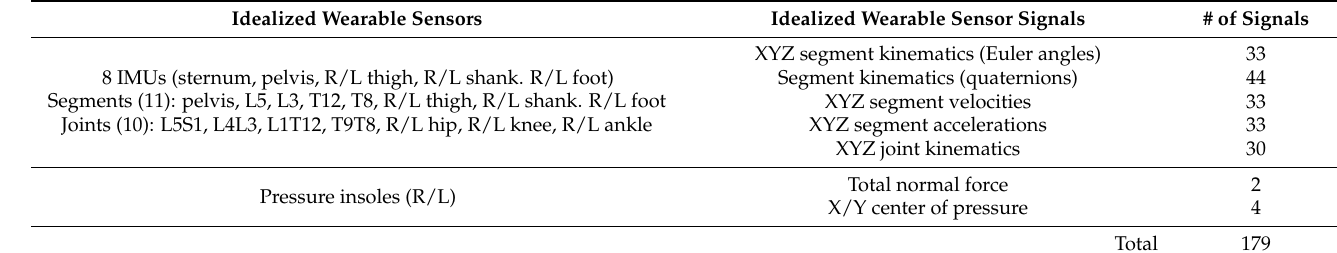
Table 2. Real wearable sensor signals. R = right; L =